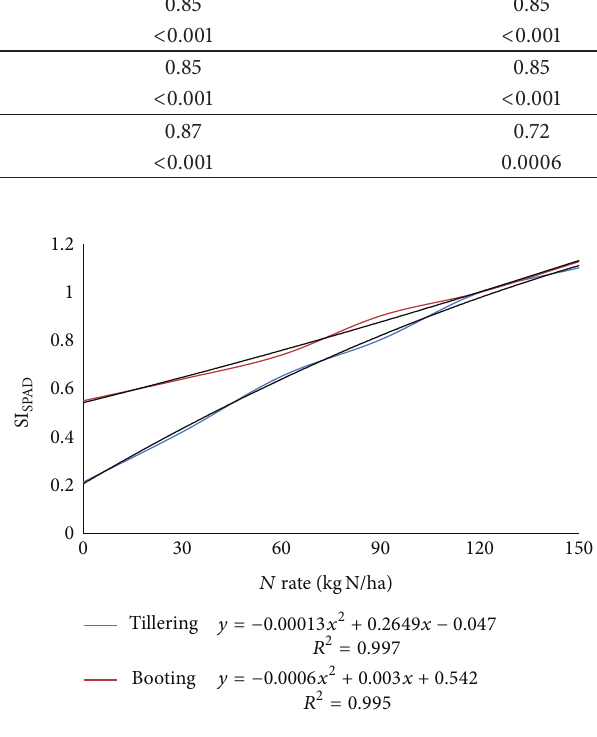
Figure 4: Quadratic response model from regression analyses of relative chlorophyll meter readings (SI SPAD ) and N fertilizer rate at tillering and booting